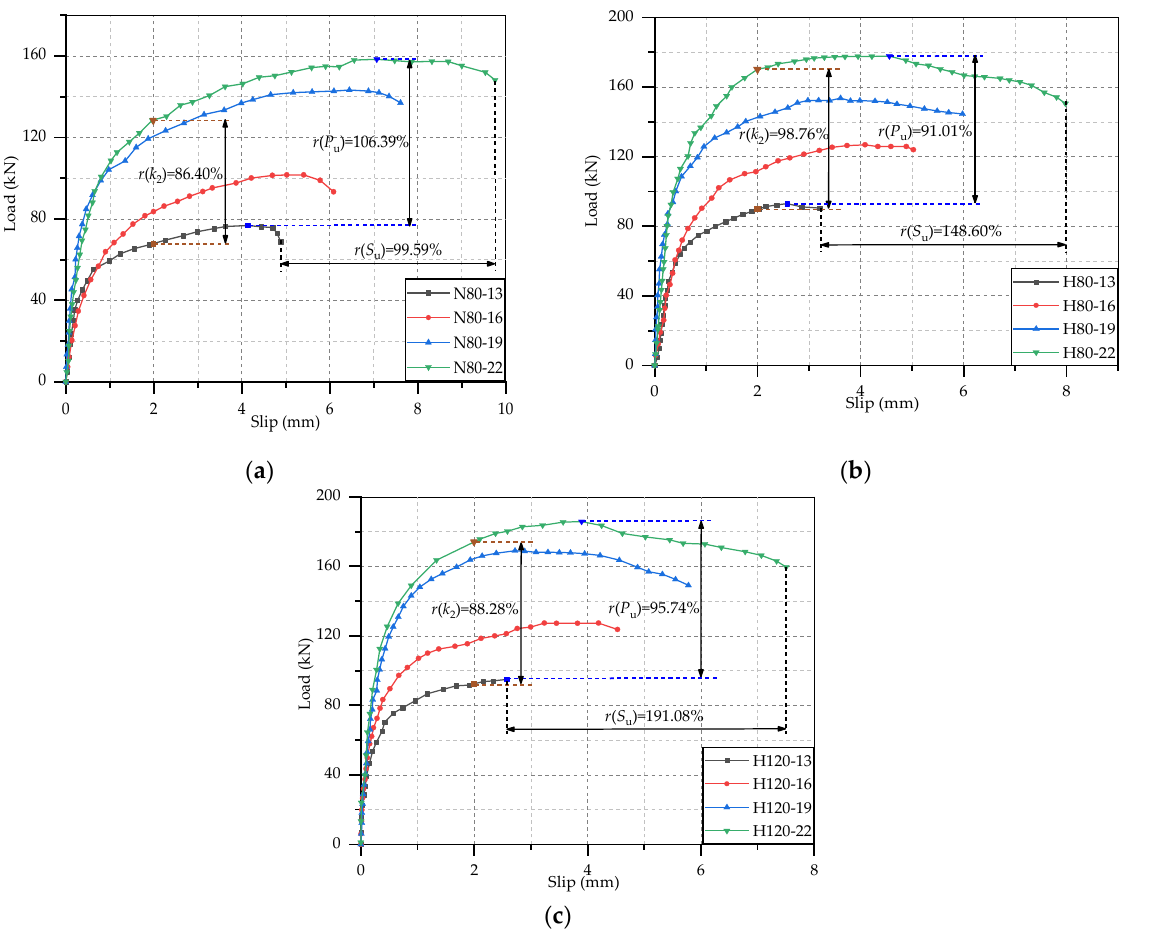
Figure 6. Effect of stud diameter: ( a ) N80-13~22; ( b ) H80-13~22; ( c ) H120-13~22.